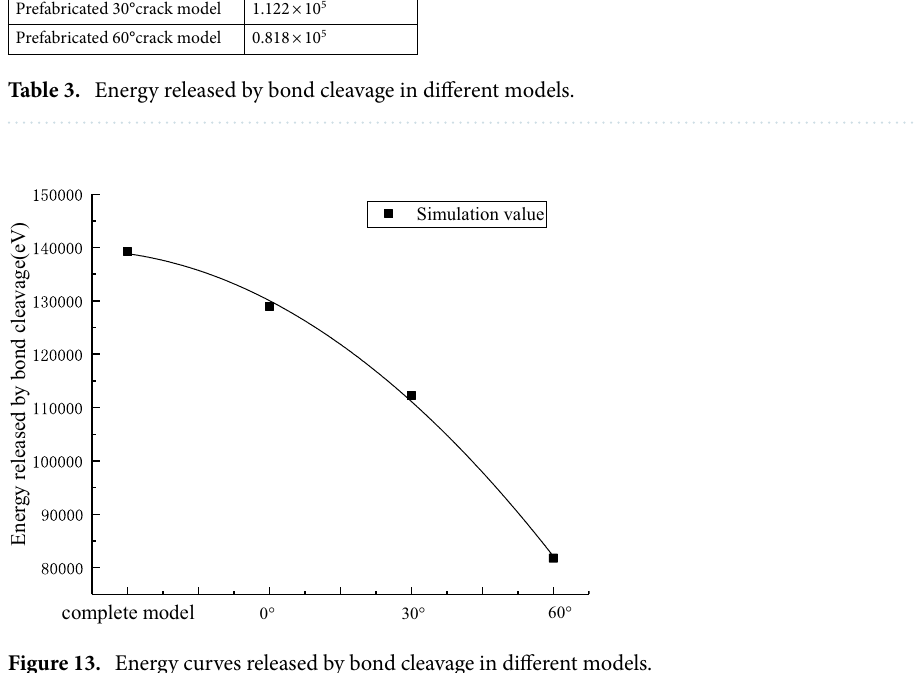
Figure 13. Energy curves released by bond cleavage in different